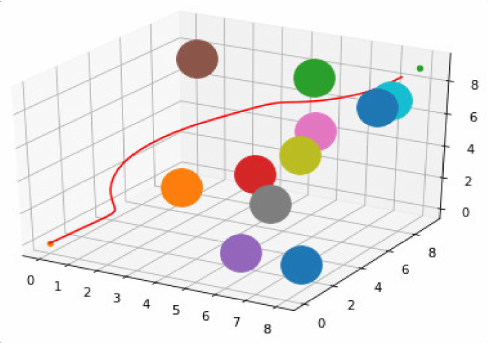
Figure 5. I-APF method path